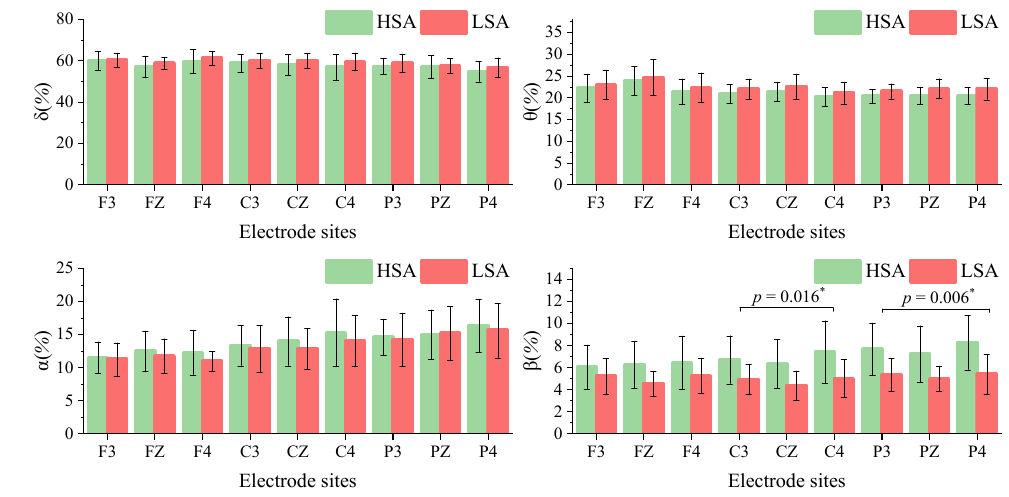
Figure 4. Relative power for the two SA groups.